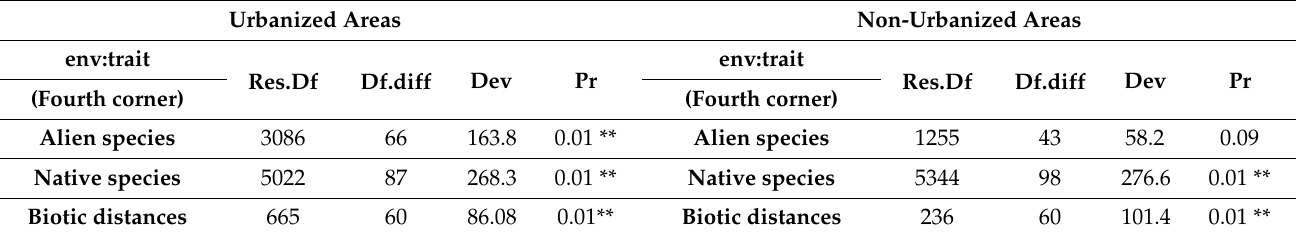
Table 1. Results of fourth corner analysis using 999 permutations (probability integral transform residual bootstrap (PIT-trap) block resampling, which accounts for correlation) for alien and native plant groupings, as well as biotic distances between the two species